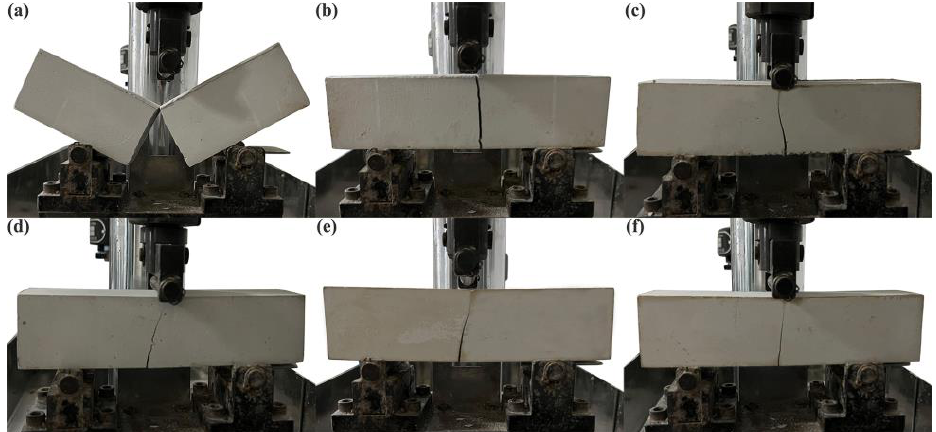
Figure 14. The failure testing process of the flexural strength. ( a ) PBGC-NWF; ( b ) PBGC-UWF; ( c ) PBGC-MWF1; ( d ) PBGC-MWF2; ( e ) PBGC-MWF3; ( f ) PBGC-MWF4.